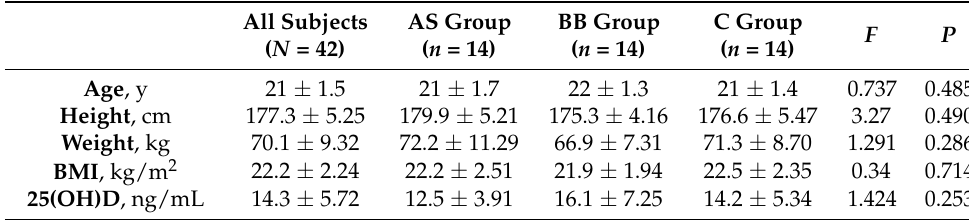
Table 1. Subject characteristics at